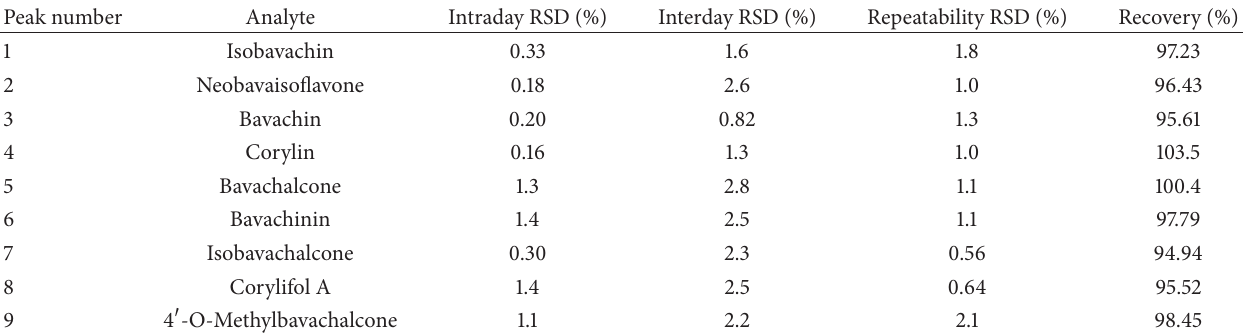
Table 3: Accuracy, repeatability, and recovery of markers in P. corylifolia L . samples ( 𝑛 = 6